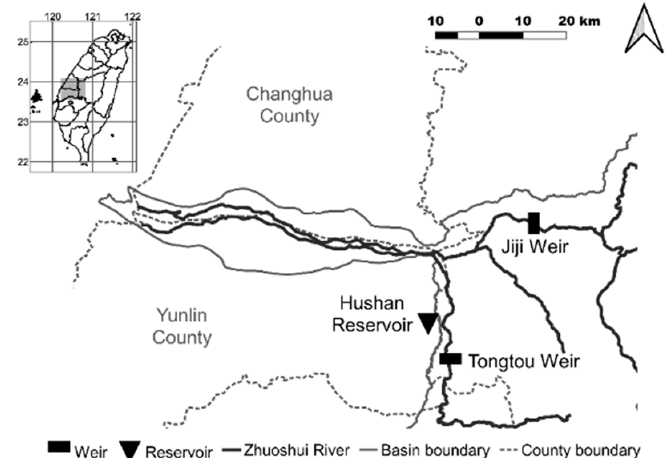
Figure 2. Location of study area.